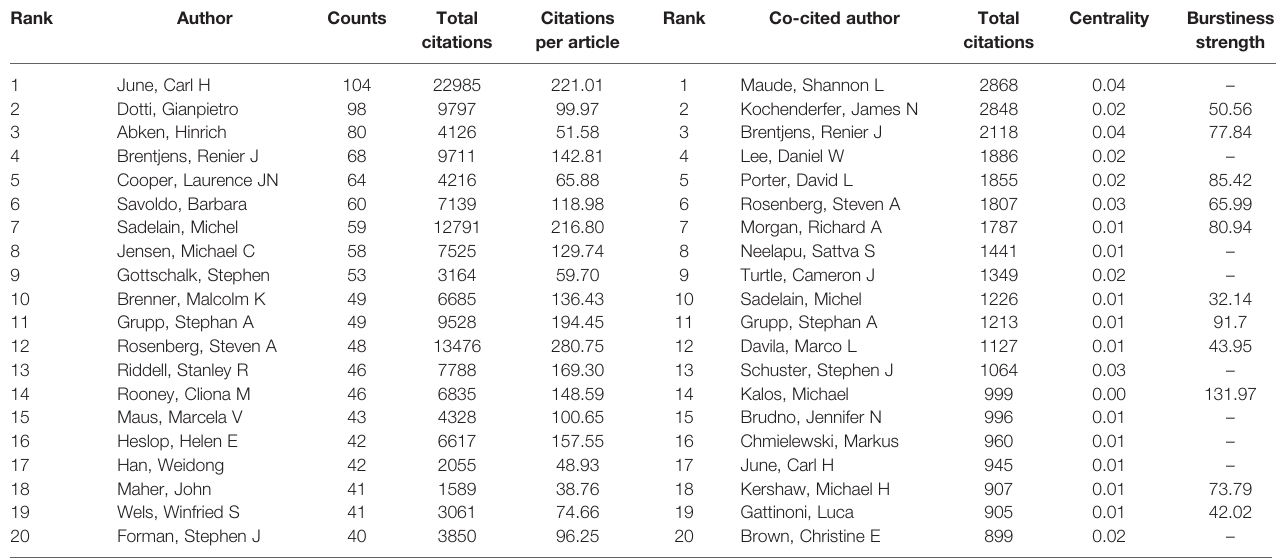
TABLE 3 | Top 20 most relevant authors and co-cited authors related to CAR-based